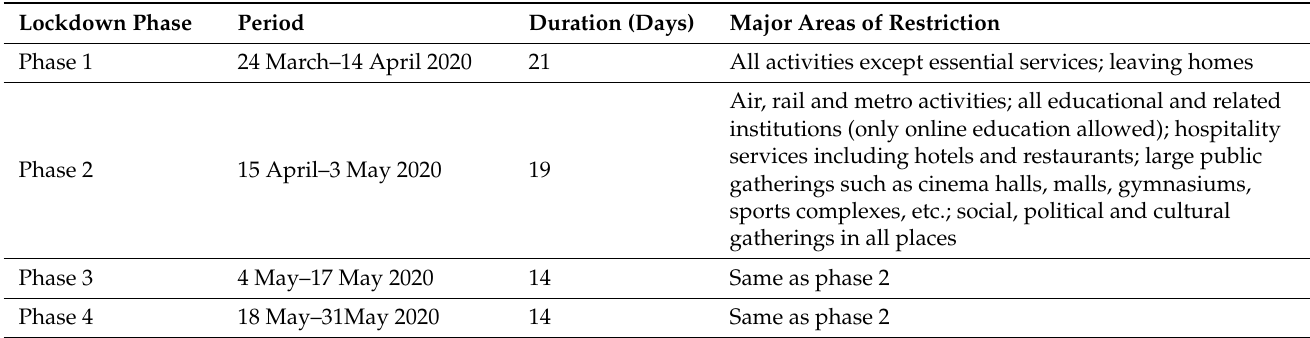
Table 1. Lockdown and unlocking phases in India, duration and areas closed/opened (excluding